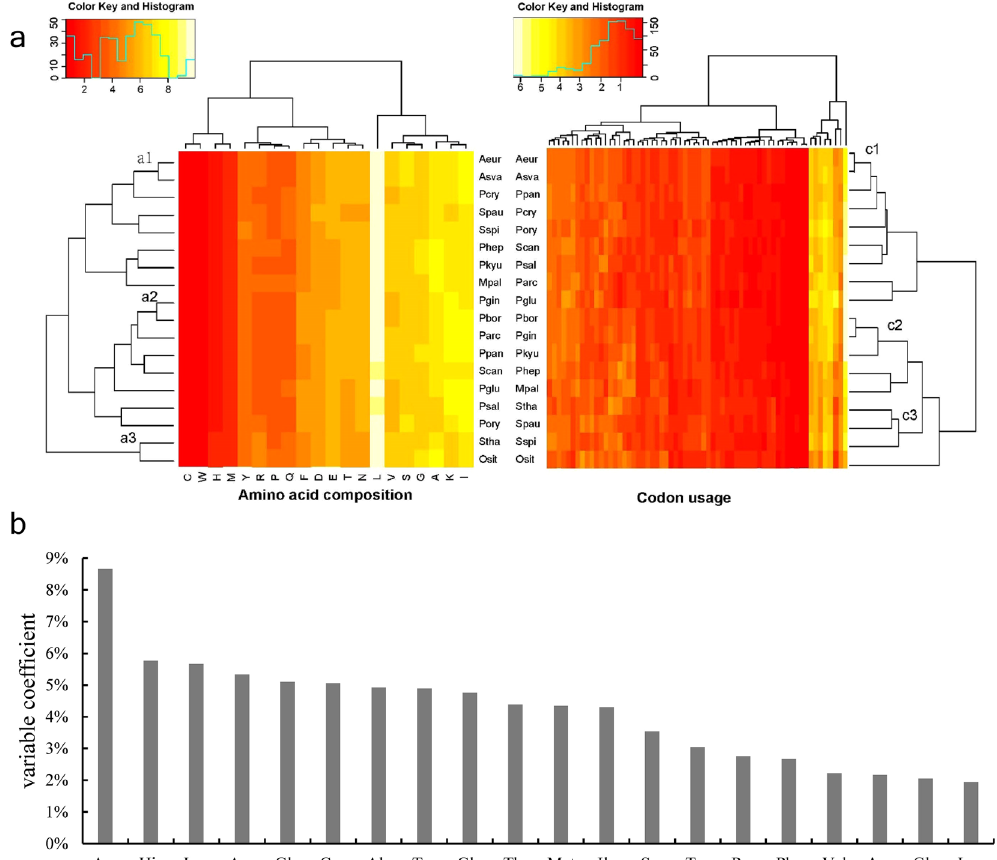
Figure 2. ( a ) Amino acid and codon usage heat maps. Key: Aeur, Arcticibacter eurypsychrophilus MJ9-5; Asva, Arcticibacter svalbardensis MN12-7; Mpal, Mucilaginibacter paludis DSM18603; Osit; Olivibacter sitiensis DSM17696; Parc, Pedobacter arcticus A12; Pbor, Pedobacter borealis DSM 19626; Pcry, Pedobacter cryoconitis PAMC 27485; Pgin, Pedobacter ginsenosidimutans KACC 14530; Pglu, Pedobacter glucosidilyticus DSM 23534; Phep, Pedobacter heparinus DSM 2366; Pkyu, Pedobacter kyungheensis KACC 16221; Pory, Pedobacter oryzae N7; Ppan, Pedobacter panaciterrae O48; Psal, Pedobacter saltans DSM 12145; Scan, Solitalea canadensis DSM 3403; Spau, Sphingobacterium paucimobilis HER 1398; Sspi, Sphingobacterium spiritivorum ATCC 33861 and Stha, Sphingobacterium thalpophilum DSM 11723). ( b ) Variable coefficients of amino acid composition between the 18